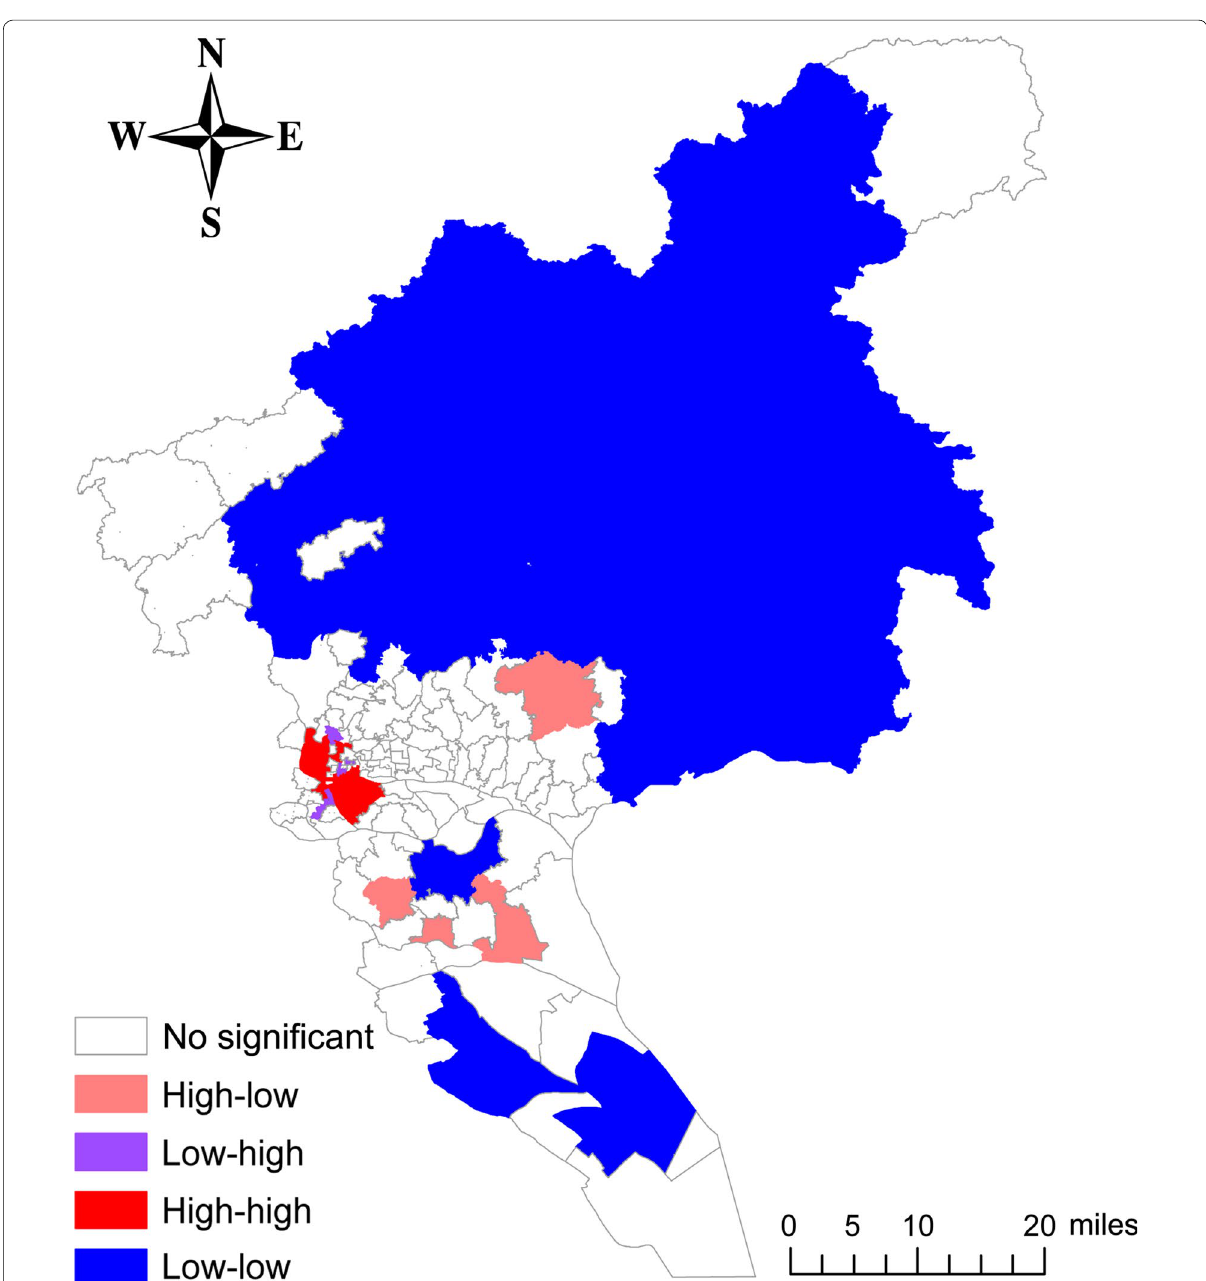
Fig. 2 Local hot spot map for colorectal cancer incidence in Guangzhou, China during 2010–2014. High–high: clusters of streets with high inci‑ dences. Low‑low: clusters of streets with low incidences. High–low: streets with high incidences surrounded mainly by streets with low incidences. Low–high: streets with low incidences surrounded mainly by streets with high incidences. High‑high clusters include 25 streets in central urban areas. Low–low clusters include 30 streets in most suburban